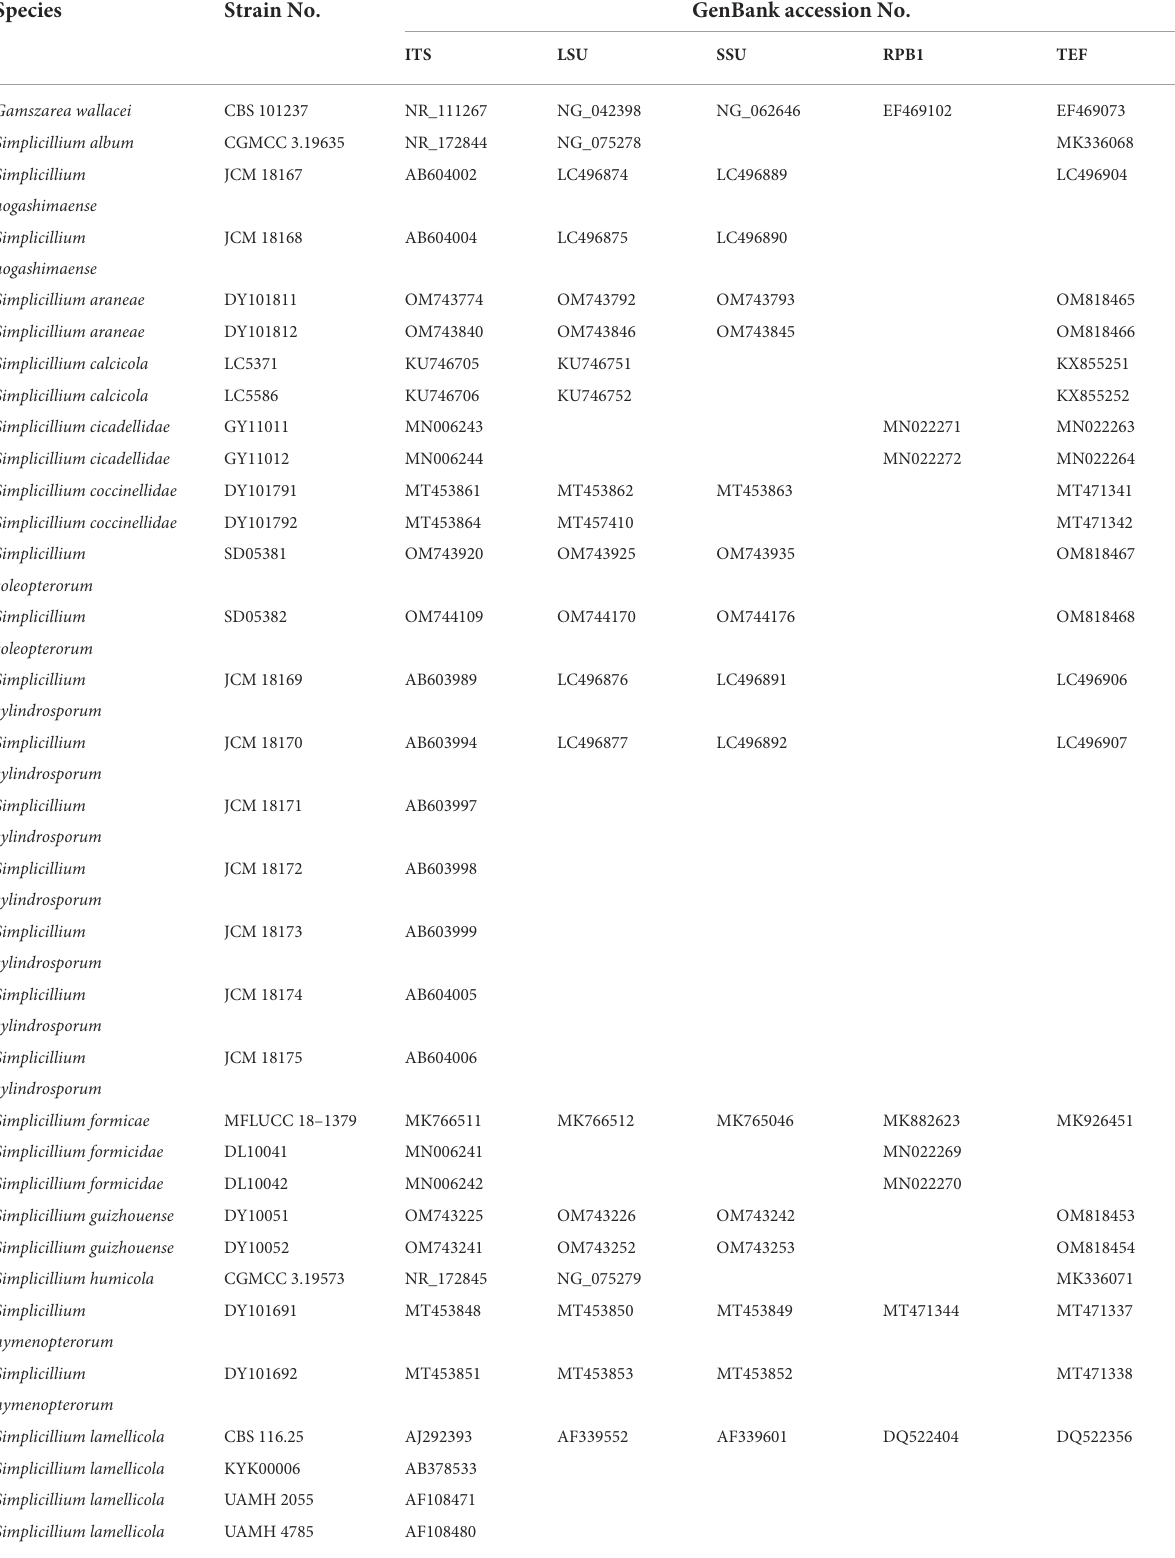
TABLE 1 Taxa included in the phylogenetic analyses. Species Strain No. GenBank accession